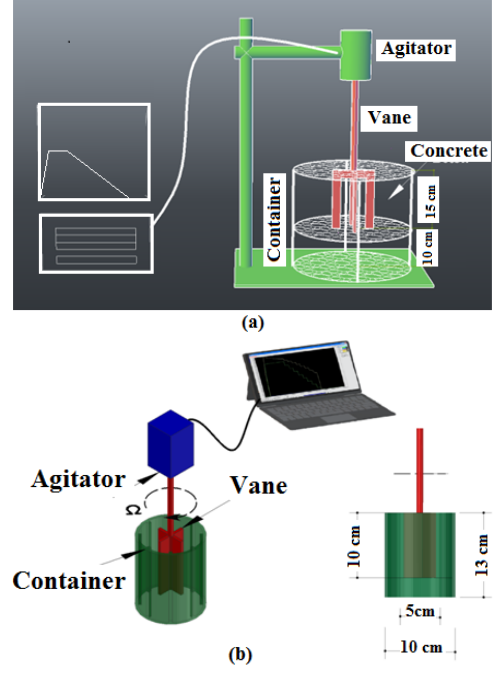
Figure 5: Rheometer and the steel vane for (a) concrete and (b) cement mortar.